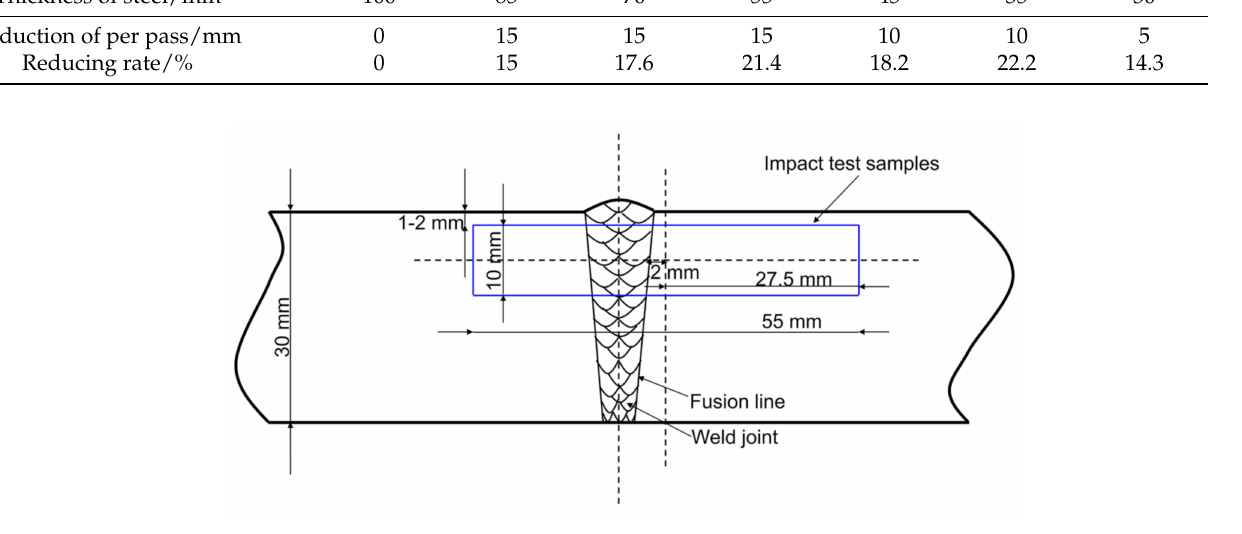
Figure 1. Schematic diagram of the machining locations of Charpy V-notch impact